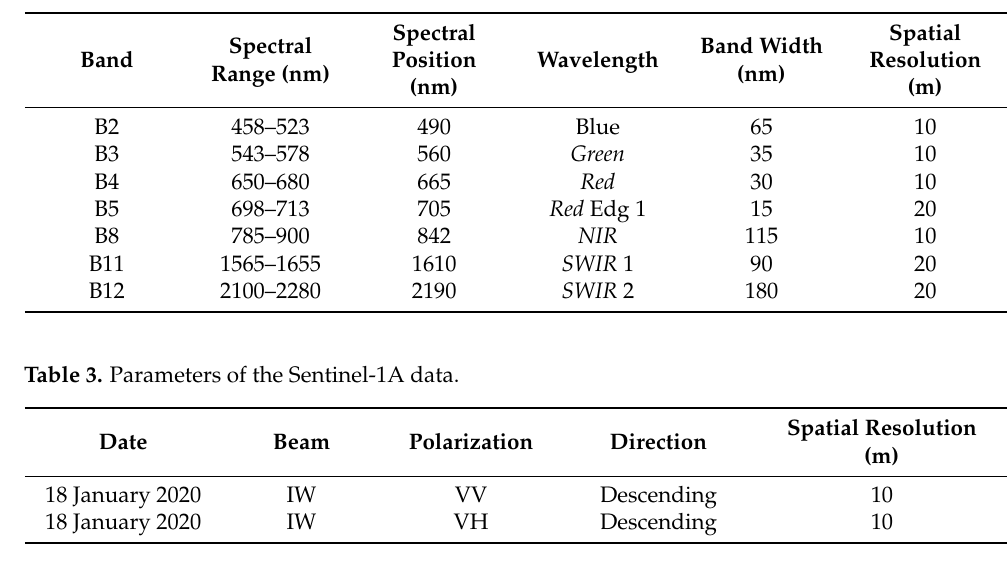
Table 2. Technical specifications of Sentinel-2A bands used in this study.